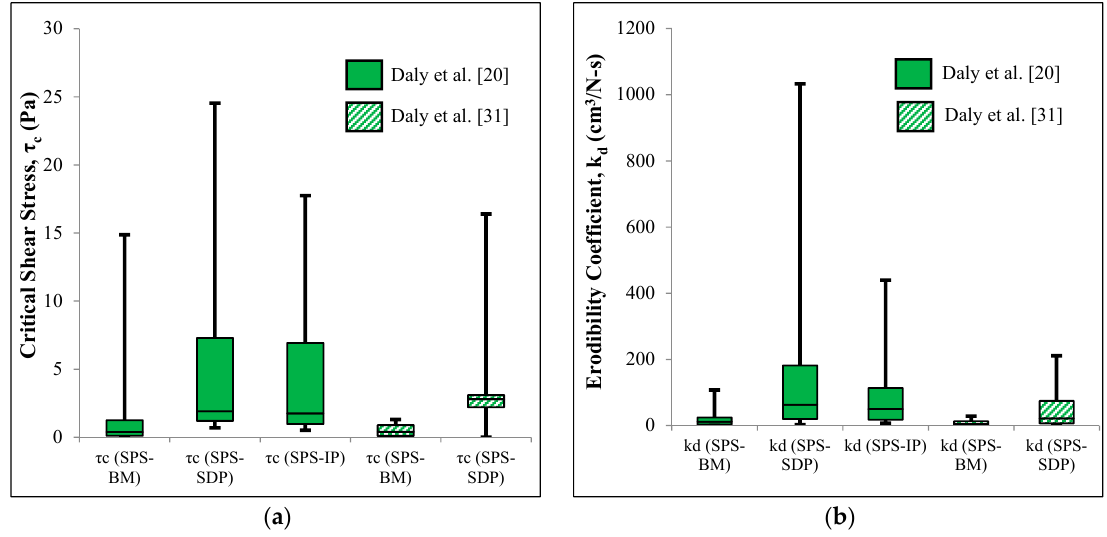
Figure 10. Comparison of ( a ) critical shear stress ( τ c ) and ( b ) erodibility coefficient ( k d ) using the SPS-BM, SPS-SDP and SPS-IP methods based on data from Daly et al. [20,31].